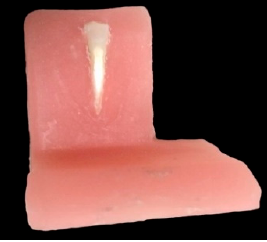
Figure 1. The flat platform created on a lower incisor tooth was fixed to a specially designed acrylic block.